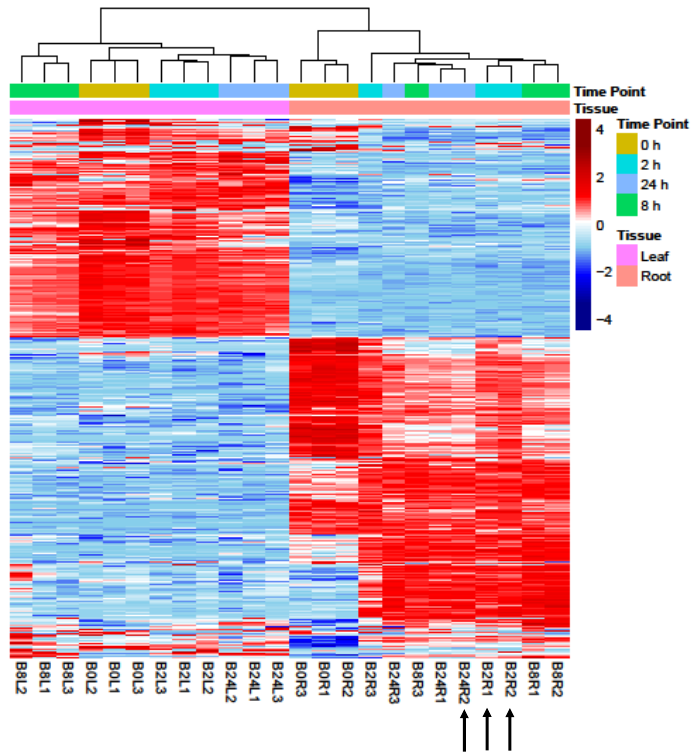
Figure 1. Cluster analysis using 25% highly variable genes. Gene expression in leaf (pink) and root (orange) was assessed under salt (200 mM NaCl) treatment for 2, 8, and 24 h relative to untreated plants (0 h). Samples and biological replicates (L1, L2, and L3 for leaves and R1, R2, and R3 for roots) are shown. The color gradient (upper right) indicates the pattern of expression from lowly (blue) to highly (red) expressed genes and ranges from − 4- to +4-fold changes in expression. Sampling time point and tissue type are shown at the top of the cluster plot and defined on the right. The dendrogram at the top shows the sample clustering, and the black arrows indicate the samples that did not cluster by time point in the